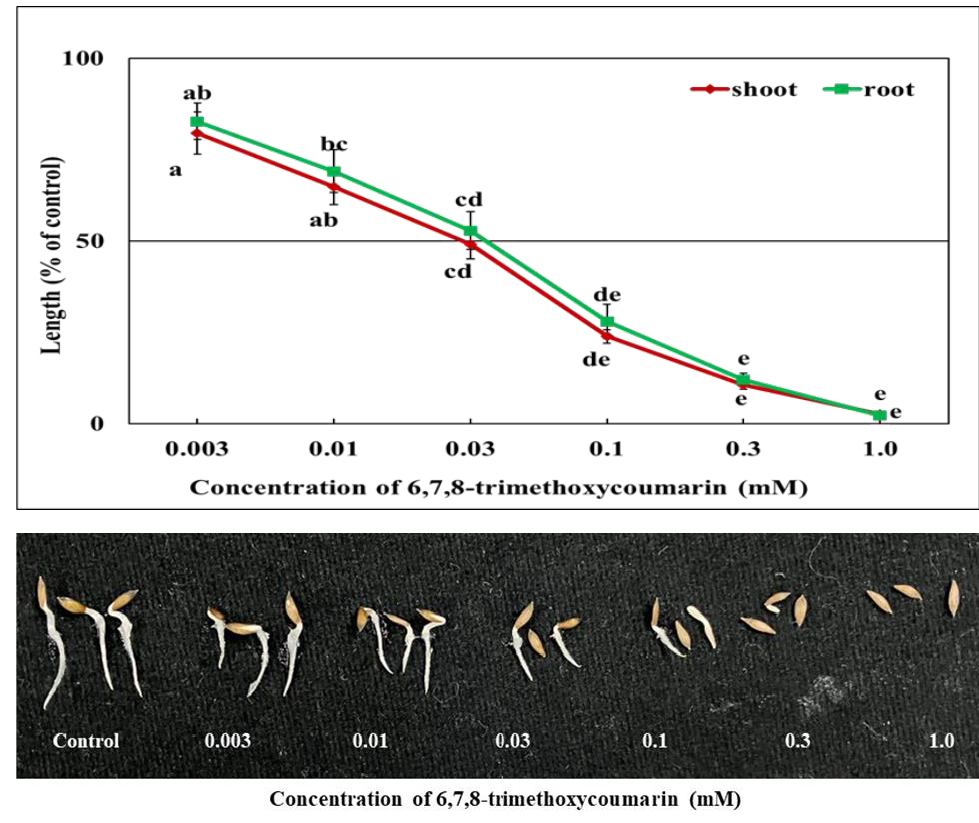
Figure 7. The effects of the 6,7,8-trimethoxycoumarin treatment on the growth (shoot and root) of lettuce seedlings. Mean ± SE of each experiment replicated 3 times ( n = 30). Differences between the control and treatment are represented by different letters (Tukey’s HSD at p ≤ 0.05).